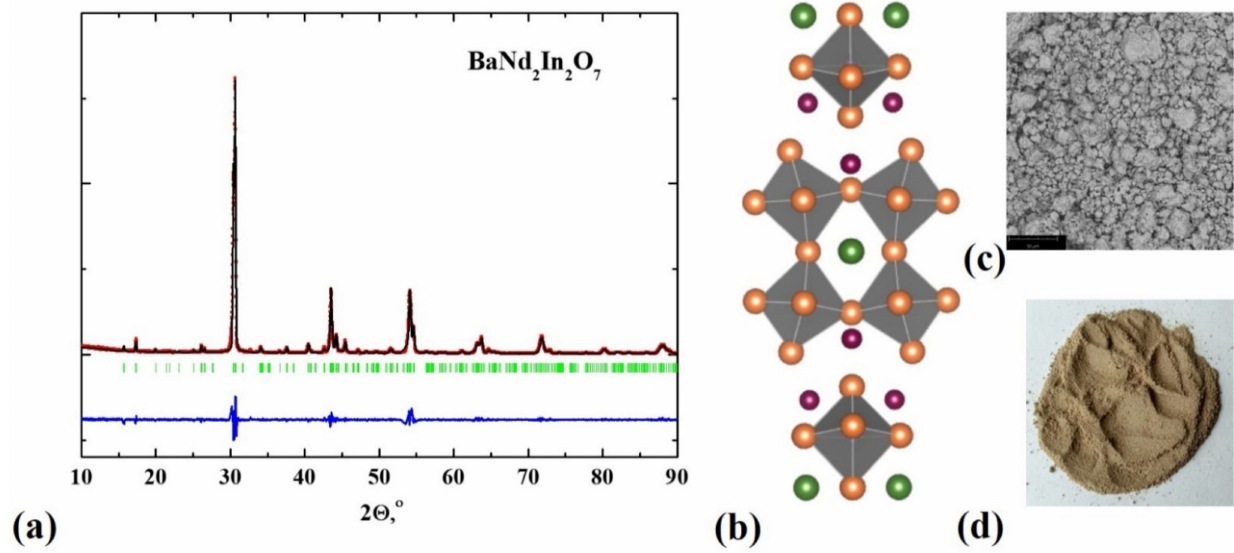
Figure 2. Materials characterization of the BaNd 2 In 2 O 7 compound: XRD patterns ( a ), image of double-layered RP crystal structure ( b ), SEM-image ( c ), and image of powder sample ( d ). Table 1. Unit cell parameters and volume of the BaNd 2 In 2 O 7 and BaLa 2 In 2 O 7 compounds.